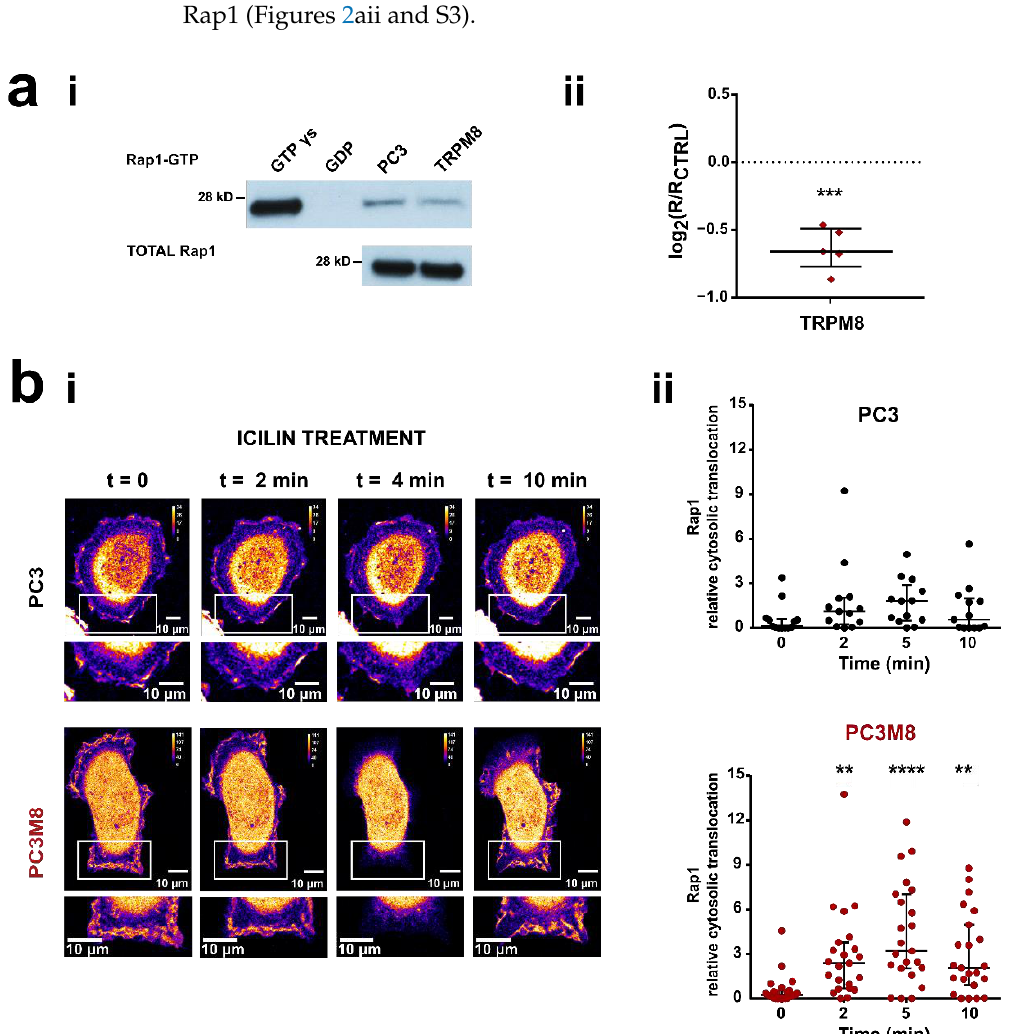
Figure 2. TRPM8 decreases Rap1 activation. ( ai ) Active Rap1 pull-down assay on PC3 and PC3 overexpressing TRPM8. The original uncropped blot is reported in Figure S2. ( aii ) Quantification of the active Rap1 as the ratio between Rap1-GTP over total Rap1 (R) normalized on this ratio on PC3 (R CTRL ). Data are expressed as log 2 and shown in the scatter dot plot in which each dot represents one single experiment and lines represent mean ± SEM. Statistical significance versus PC3, ***: p < 0.001 (One sample t -test). ( bi ) Live-cell imaging by confocal microscopy of PC3 and PC3M8 expressing GFP-RBD RalGDS probe. Representative images showing GFP-RBD RalGDS in PC3 and PC3M8 at t = 0 and after 2, 4 and 10 min of treatment with 10 µ M icilin; the bottom parts of the figures represent enlargement of the inset (white box) for each time point. ( bii ) Scatter dot plots showing the quantification of GFP-RBD membrane recruitment calculated as cytosol translocation as described in the method section. Each dot represents one cell (83 regions of interest [ROIs] referring to 13 cells for PC3 and 100 ROIs referring to 23 cells for PC3M8) and lines show median ± interquartile range. Statistical significance versus t = 0, **: p < 0.005; ****: p < 0.0001 (Kruskal–Wallis test with Dunn’s post-hoc